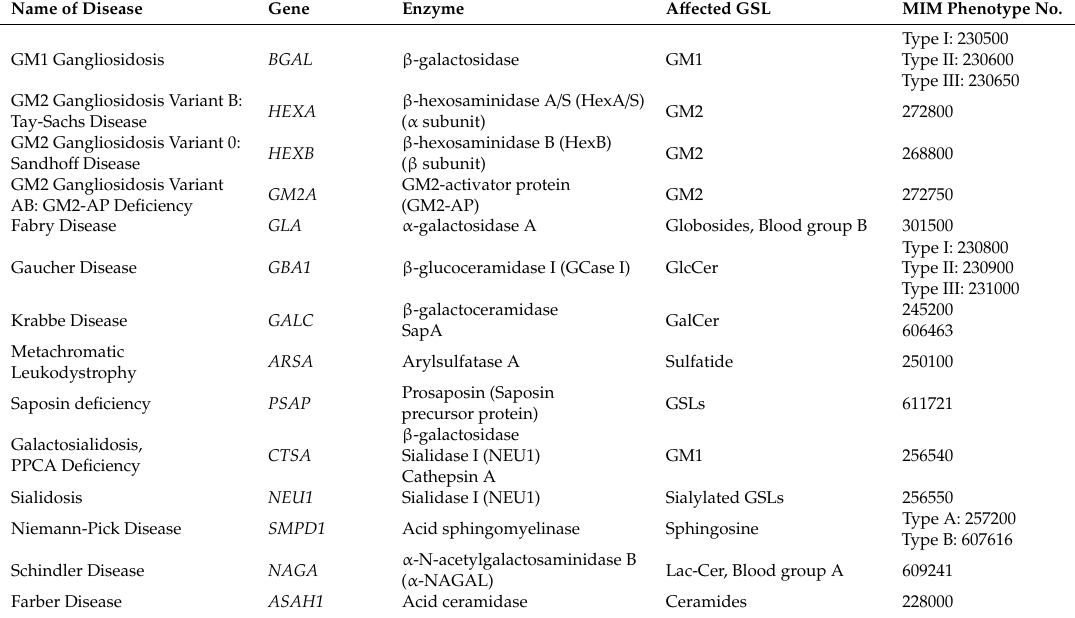
Table 4. Disorders of glycosphingolipid